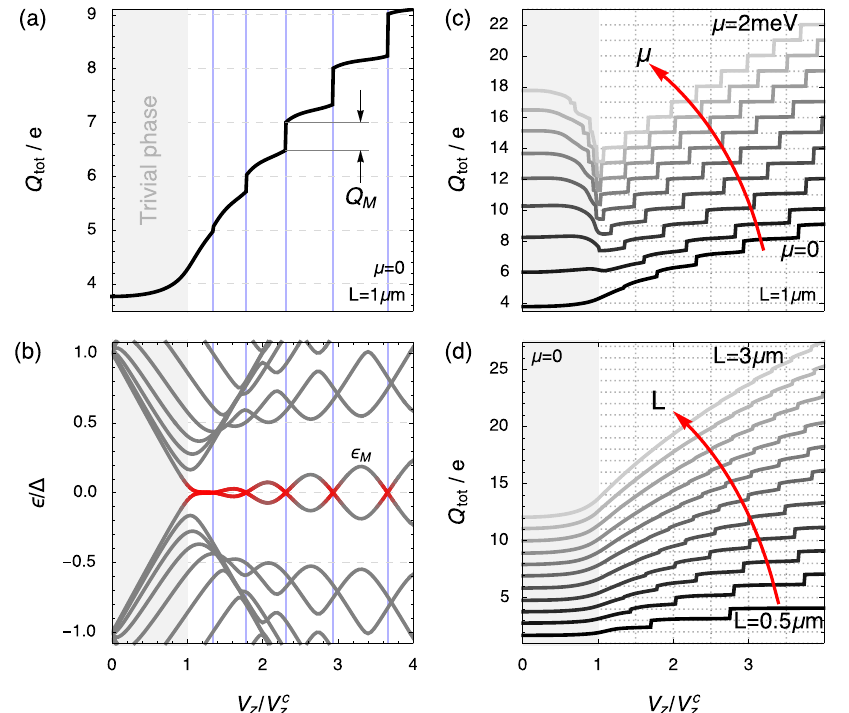
Fig. 2 a Total charge Q tot in a non-interacting topological nanowire vs. V Z . For V Z > V Zc , Q tot increases in jumps of magnitude Q M < e at parity crossings, shown in red in b . c , d Charge jumps become more (less) quantized as μ ( L )